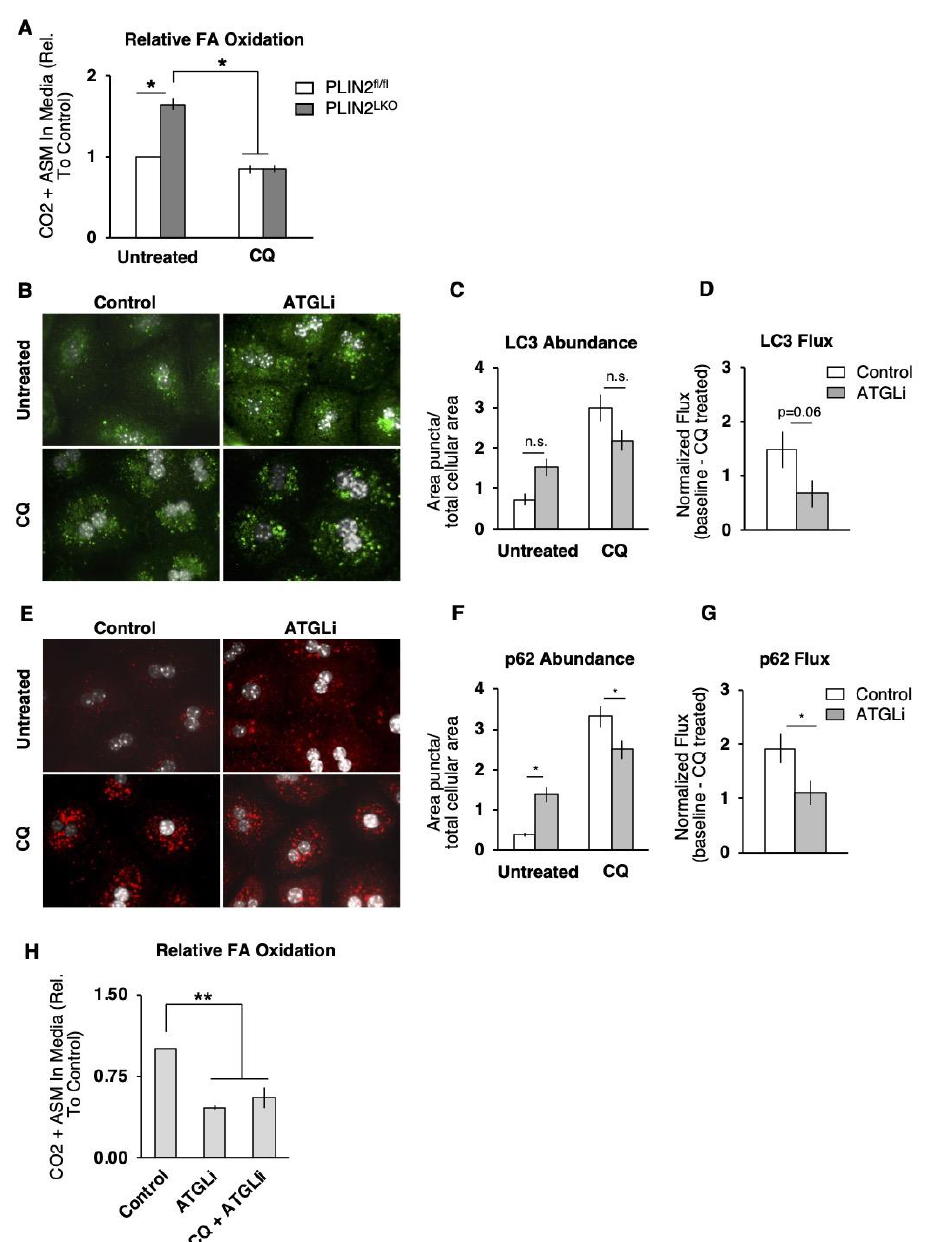
Figure 5. The integrated actions of lipophagy and ATGL increase FA oxidation in PLIN2-deficient hepatocytes. ( A ) 14 C-labeled CO 2 and acid-soluble metabolites in the media of primary hepatocytes isolated from 8-month-old mice incubated with 500 uM oleic acid (0.1 µ Ci/mL 14 C-oleic acid) for 2 h and chased for 4 h in the presence of 100 µ M chloroquine (CQ), n = 3 mice/group, expressed relative to PLIN2 fl/fl . ( B – G ) Immunostaining of endogenous autophagosomal markers LC3 ( B – D ) and p62 ( E – G ) in fixed primary hepatocytes isolated from 12-week-old mice incubated for 6 h in serum free M199 media with and without 100 µ M CQ. Quantification of puncta and flux was performed from 30 representative cells per treatment. Flux is expressed as the average increase in puncta following CQ treatment for each cell relative to the untreated group average. ( H ) 14 C-labeled CO 2 and acid-soluble metabolites in the media of primary hepatocytes isolated from 3-month-old PLIN2 LKO mice incubated with 500 µ M oleic acid (0.1 µ Ci/mL 14 C-oleic acid) for 2 h and chased for 4 h in the presence of 30 µ M ATGListatin (ATGLi), or 30 µ M ATGLi + 100 µ M CQ. n = 3–4 mice/group, expressed relative to untreated. Data are presented as the mean ± SEM * p ≤ 0.05, ** p ≤ 0.01, as determined by ( A – G ) two-way ANOVA and ( H ) one-way ANOVA and Tukey’s post hoc